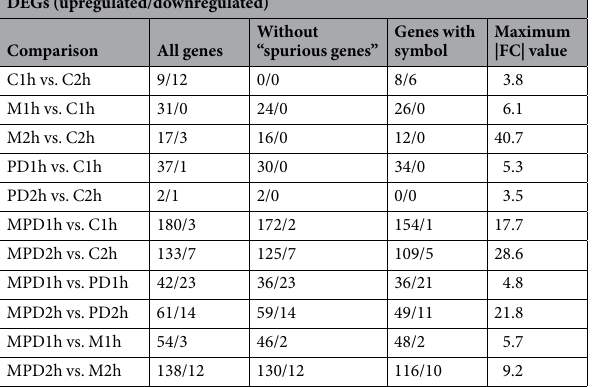
the same units (log2-intensity values) and b) we considered that, by giving more weight to the highly expressed genes, we would obtain a result that reflects more faithfully the similarities between the gene expression profiles. Somehow contradictorily to what the heatmap shows, the visualization of the samples across the coordinates of the three most informative principal components reveals that, while the samples on morphine at 2 h appear on one edge of the plot, the ones under the co-treatment at 2 h lie much closer to the control samples (Fig. 2B). This suggests that the addition of the PD to the morphine counteracts the effects of the latter on gene expression at